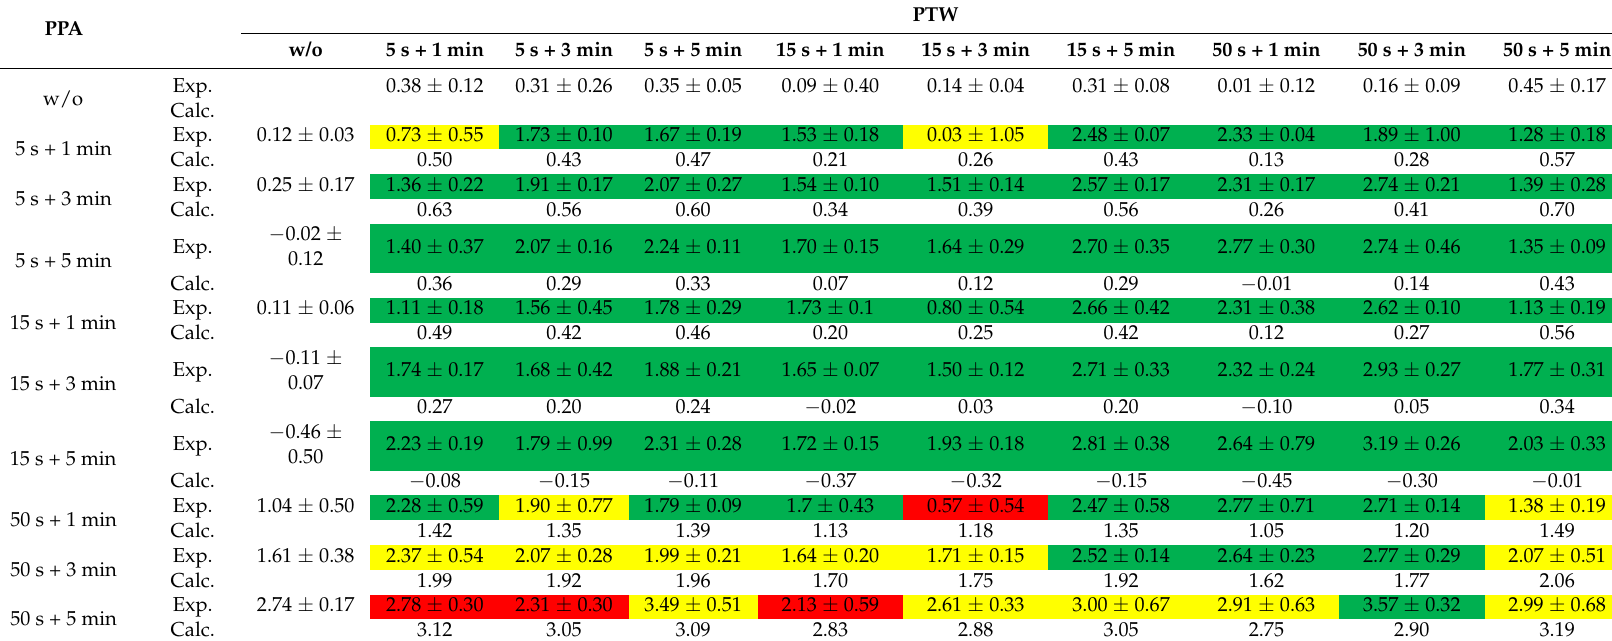
Table 6. Experimental and calculated data of separated and combined use of PPA (plasma-processed air) and PTW (plasma-treated water) under different pre- and post-treatment times for antimicrobial effects on endospores of B. atrophaeus . Color code for effects of combined PTW/PPA treatments: red = antagonistic, yellow = additive, green = synergistic, blue = detection limit reached within the experiments. w/o = without. Exp. = experimental, Calc.=